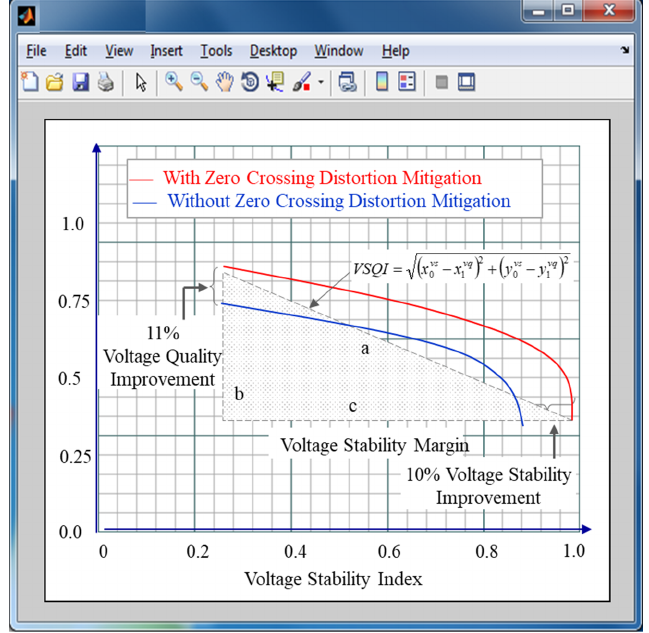
Figure 8. Voltage Stability, and Voltage Quality Improvement with and without Proposed Technique.